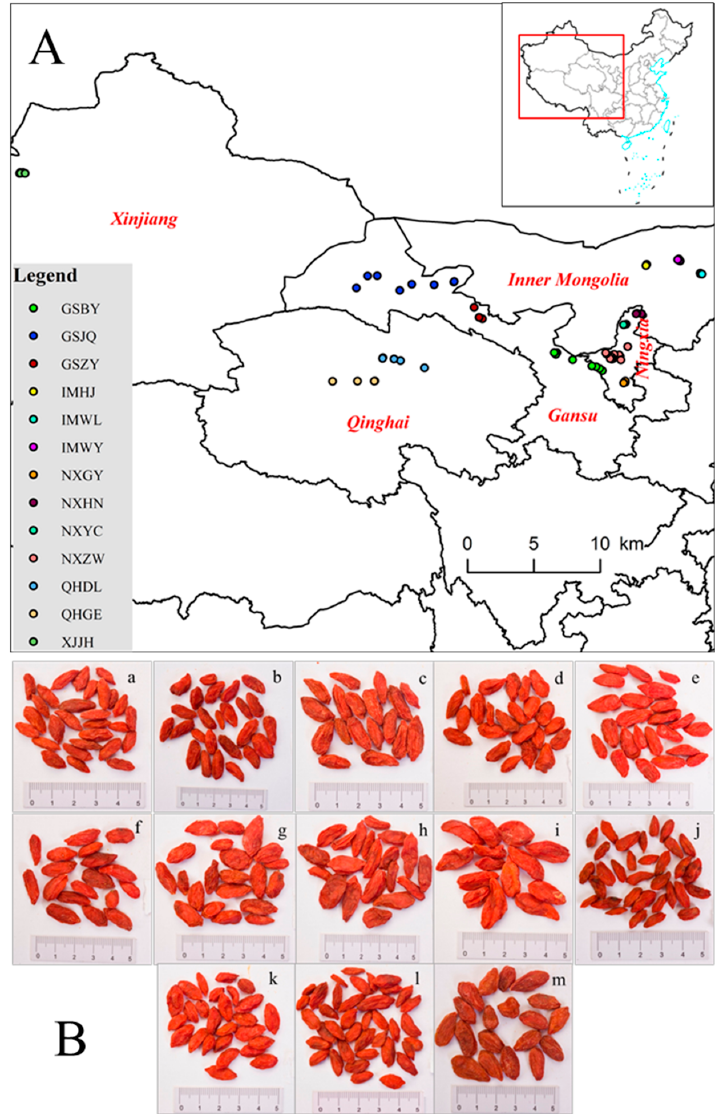
Figure 4. Sample information for the analyzed FLB (( A ) sample distribution; ( B ) materials of FLB from different regions; a: NXZW; b: NXHN; c: NXYC; d: NXGY; e: GSBY; f: GSZY; g: GSJQ; h: QHGE; i: QHDL; j: IMWL; k: IMWY; l: IMHJ; m: XJJH).